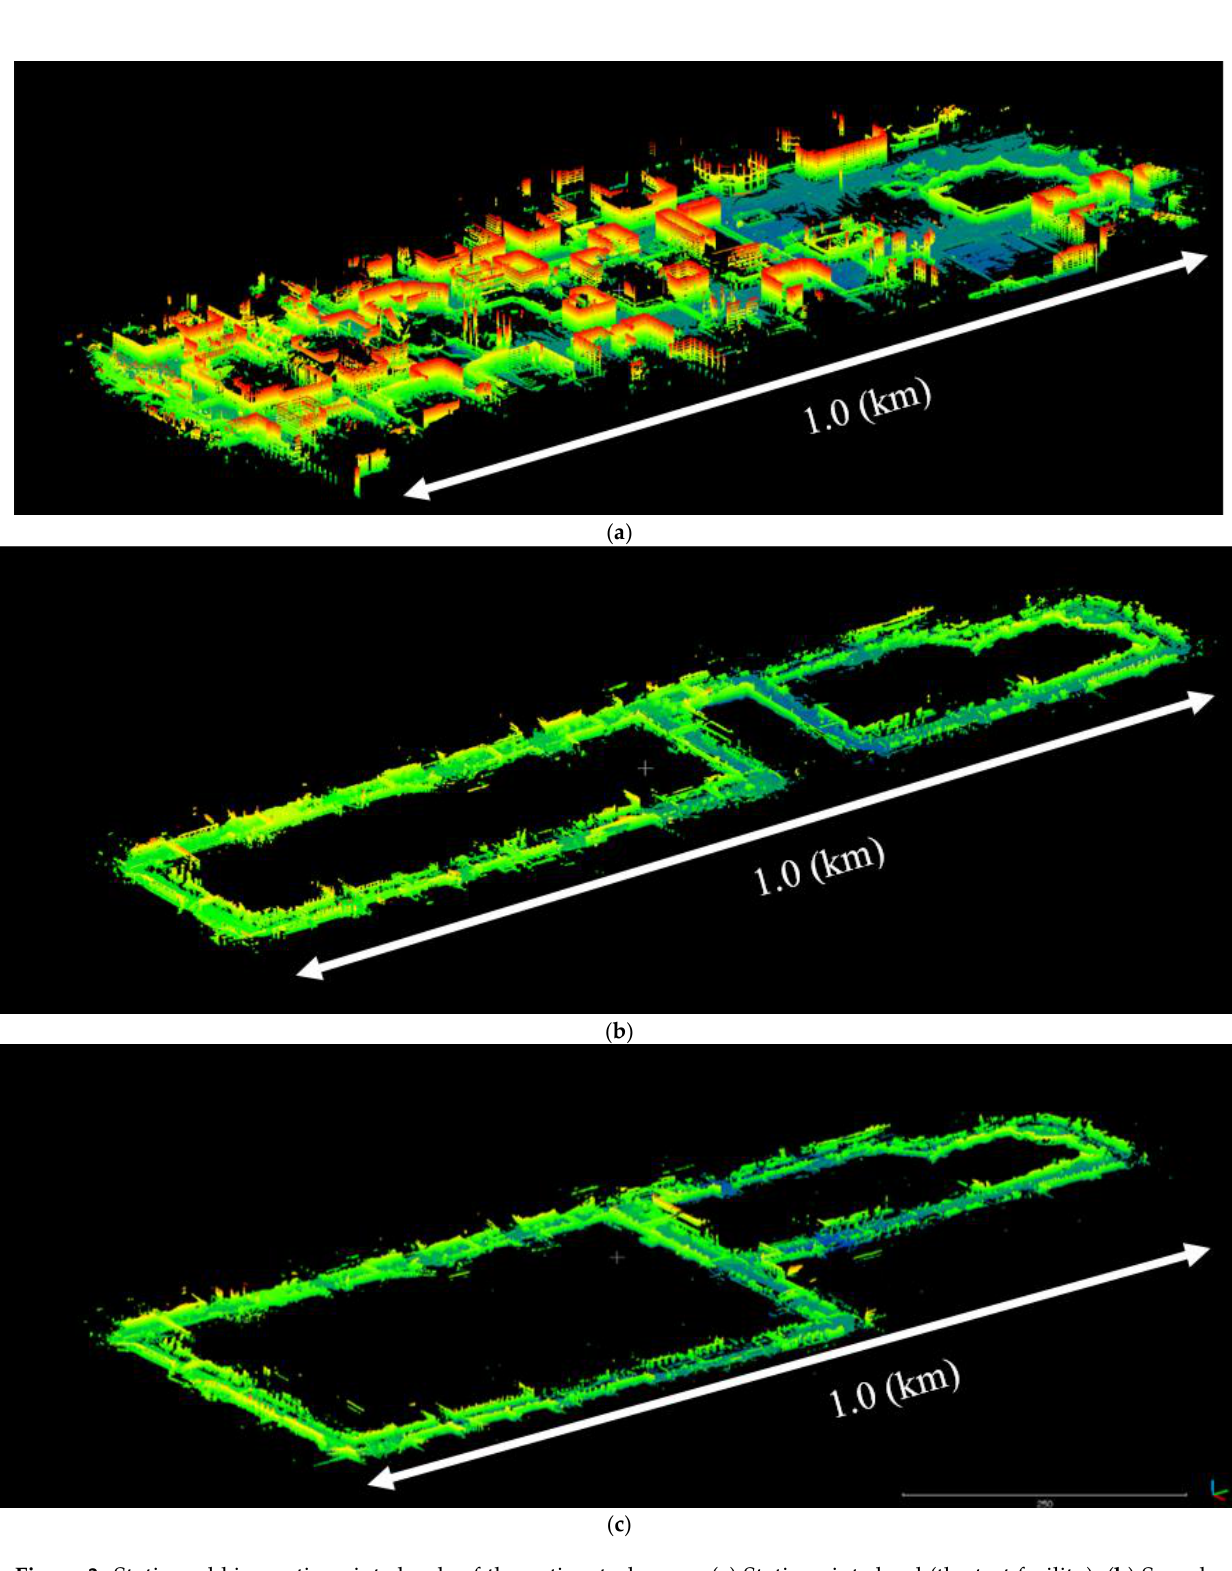
Figure 3. Static and kinematic point clouds of the entire study area: ( a ) Static point cloud (the test facility); ( b ) Sample kinematic point cloud—loop A; ( c ) Sample kinematic point cloud—loop B.